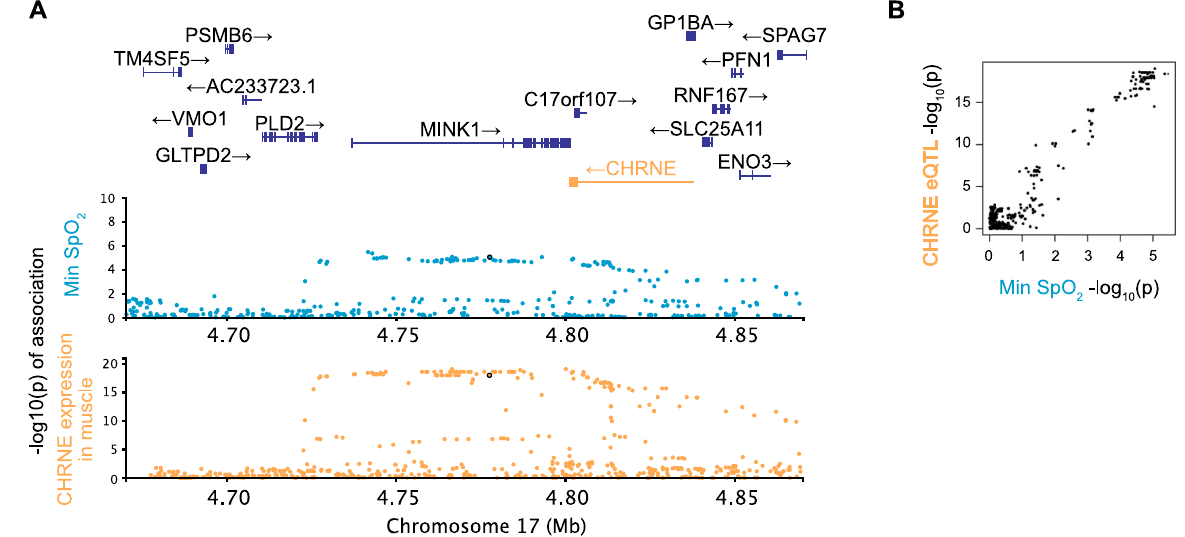
Fig 4. Pleiotropic locus linking gene expression and an OSA related trait. A locus in chromosome 17 has associations between minimum oxygen saturation (blue) and expression of CHRNE (cholinergic receptor nicotinic epsilon subunit) in muscle tissues (yellow). Gene expression trait p -values and the appropriate gene in the locus are shown in yellow. Pairwise comparisons of–log 10 ( p -values) between associated traits are shown in Panel B with matching colors in axis